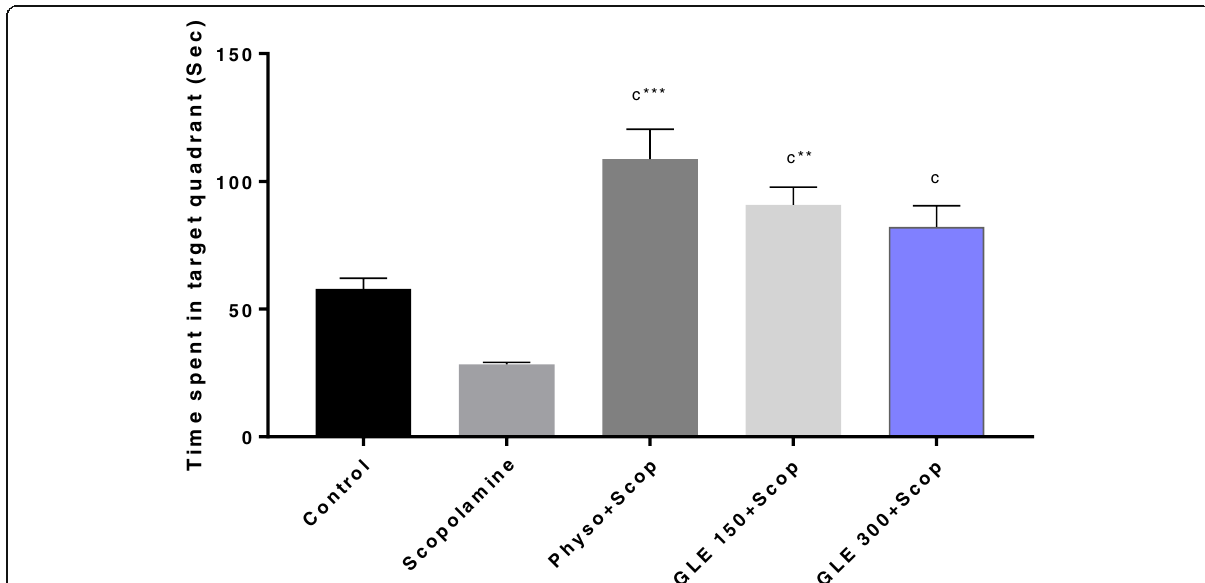
Fig. 2 Effect of Ganoderma lucidum on time spent in target quadrant (TSTQ) in MWM on 10th day of the study. Animals per group (n) = 6; The values are mean ± SEM (One-way ANOVA followed by Tukey ’ s Post hoc test). ap < 0.05, bp < 0.01, cp < 0.001 when compared with scopolamine alone treated group. * p < 0.05, ** p < 0.01, *** p < 0.0001 when compared with DW treated (control) group DW, distilled water; GLE 150, Ganoderma lucidum extract (150 mg/kg); GLE 300, Ganoderma lucidum extract 300/kg; Scop, Scopolamine; Physo,